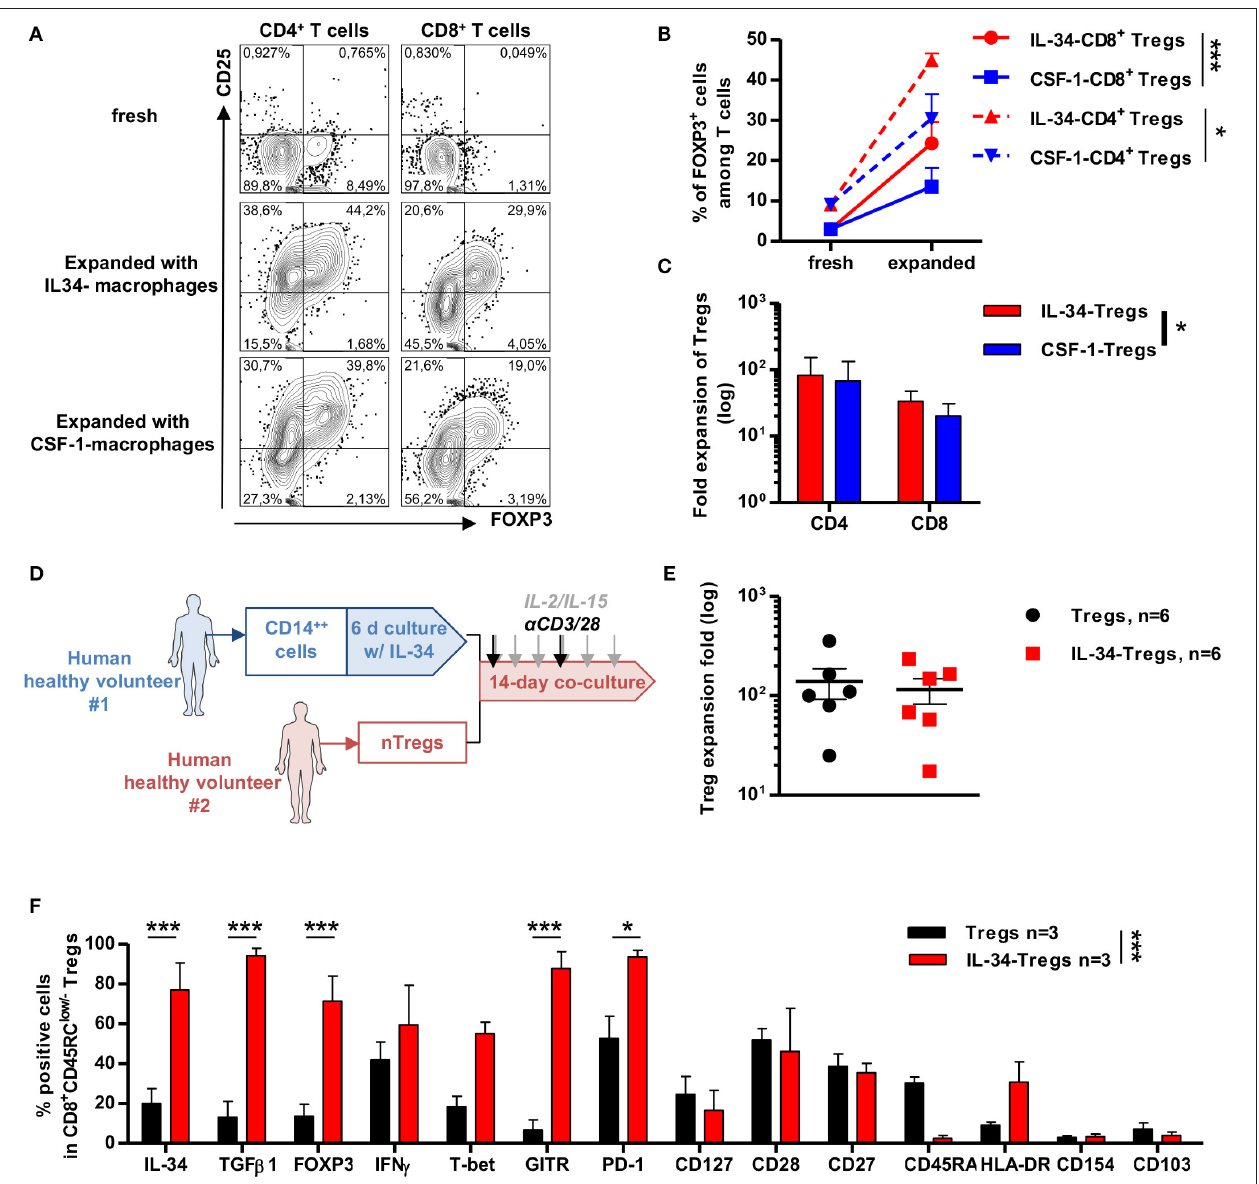
FIGURE 5 | IL-34 potentiates differentiation of CD4 + and CD8 + FOXP3 + in vitro more effectively than CSF-1. (A) Representative FACS staining of CD25 and FOXP3 expression in CD4 + (left) and CD8 + (right) T cells after 14-day culture of PBMCs with either IL-34-differentiated macrophages (middle) or CSF-1-differentiated (bottom) macrophages compared to fresh cells (upper). (B) Frequency of FOXP3 positive cells in CD4 + (dotted lines) and CD8 + (solid line) T cells before and after expansion with IL-34- (red lines) or CSF-1- (blue lines) differentiated macrophages. Two-way ANOVA, * p < 0.05, *** p < 0.001. (C) CD4 + and CD8 + Tregs count harvested after 14 days of culture with IL-34- (red bars) or CSF-1- (blue bars) differentiated macrophages in fold expansion. Two-way ANOVA, * p < 0.05. (D) Schematic depicting cell culture. CD14 ++ monocytes were sorted from a healthy volunteer (HV#1), cultured for 6 days in the presence of IL-34, then added to CD8 + CD45RC low / − Tregs harvested from another healthy volunteer (HV#2) and 14-day cultured in the presence of a polyclonal stimulation once per week and IL-2 + IL-15 supplementation three times per week. (E) Treg cell count harvested after 14 days of culture with IL-34-differentiated macrophages or freshly isolated APCs normalized to Treg cell count seeded at day 0. (F) IL-34-Tregs (red bars) were analyzed by flow cytometry for Treg-associated marker expression as compared to before expansion (fresh cells, black bars). n = 3 individuals. Two-way ANOVA and Bonferroni post-test, * p < 0.05, *** p < 0.001.